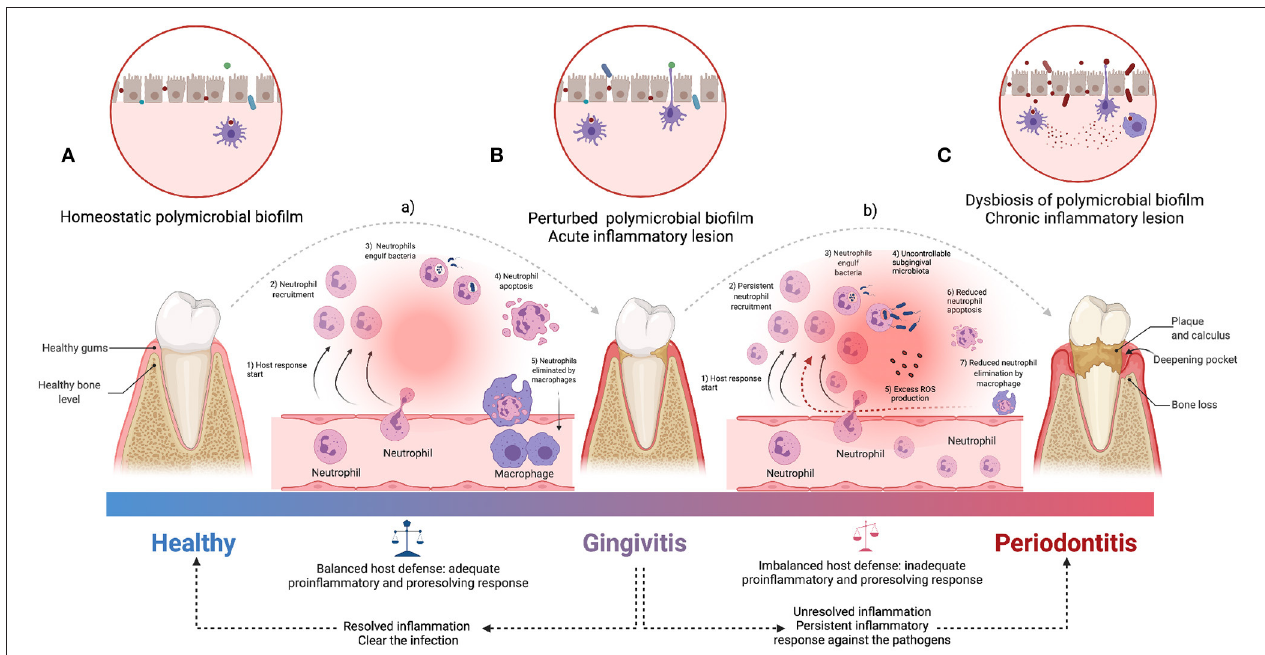
FIGURE 1 | An overview of the pathogenesis of periodontitis. The acute inflammatory process is started by the infiltration of leukocytes (a), which limit bacterial invasion of (A) homeostatic state to (B) perturbed state (of healthy conditions to gingivitis stage). The pro-resolution mediators downregulate the recruitment of immune cells and uptake of apoptotic neutrophils by macrophages to facilitate clearance of the inflammatory lesion (Adequate balance host defense). Periodontitis is characterized by both (C) dysbiosis of oral microbiota and persistent pro-inflammatory state derived from the inability to clear the infection (b), followed by unresolved lesion leading to immune cell-mediated self-destruction of periodontal tissues which results in chronic pathology (Inadequate balance host defense). ROS, Reactive oxygen species [Figure generated with BioRender